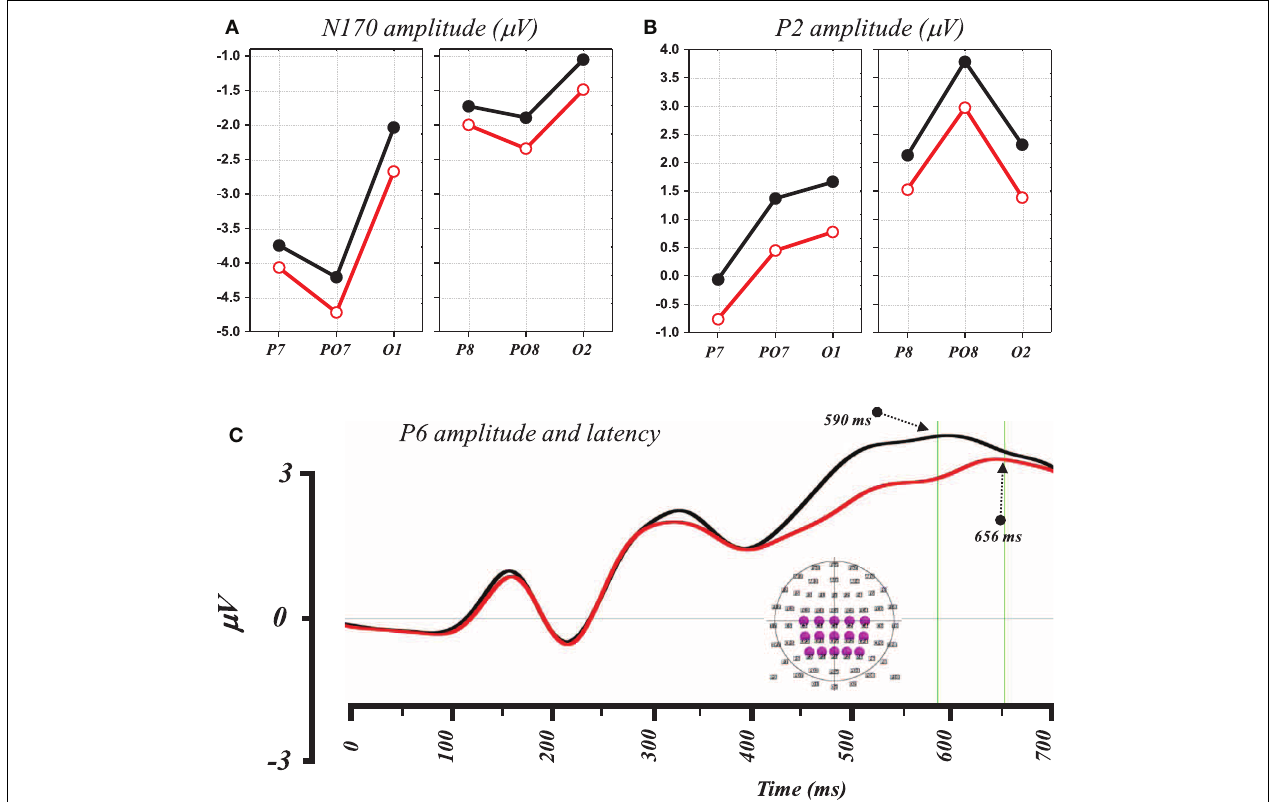
FIGURE 3 | (A) Graph showing the mean N170 amplitude at electrodes P7, PO7, and O1 (left) and P8, PO8, and O2 (right) where hemisphere (left vs. right) and condition effects were statistically observed (see text). (B) Graph showing the mean P2 amplitude at the same left and right electrodes where hemisphere (left vs. right) and condition effects were statistically observed